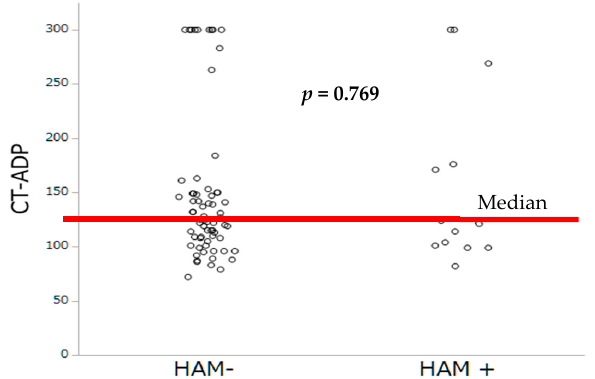
Figure 3. Occlusion time by CT-ADP according to the occurrence of HAM